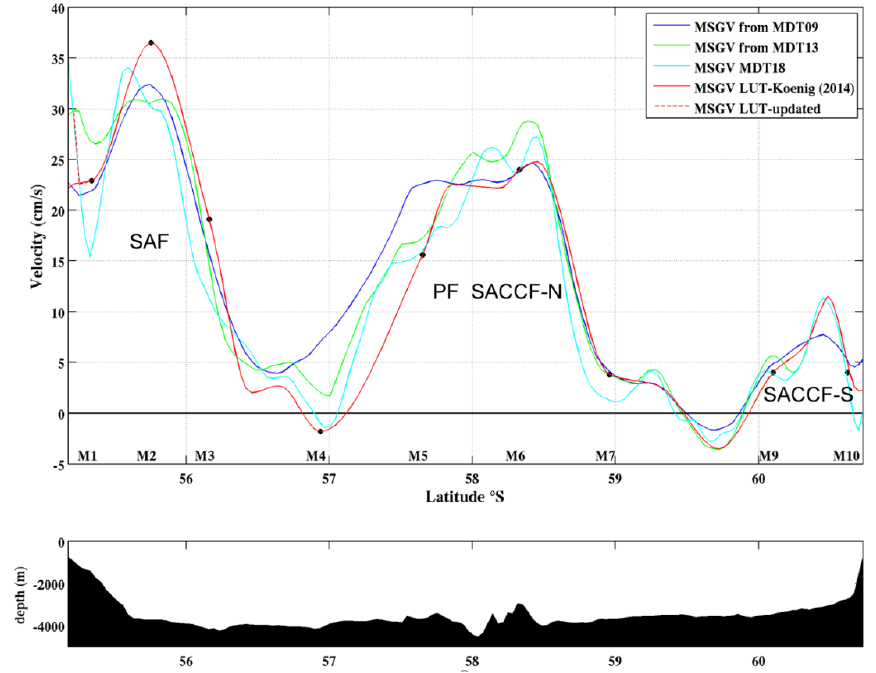
Figure 19. Mean surface geostrophic velocities (MSGVs) derived from MDT CNES-CLS09 (blue), from MDT CNES-CLS13 (green), MDT CNES-CLS18 (cyan) and LUT (red) along Jason track no. 104. Location of the Drake moorings are indicated M1 to M10. Below bathymetry along the